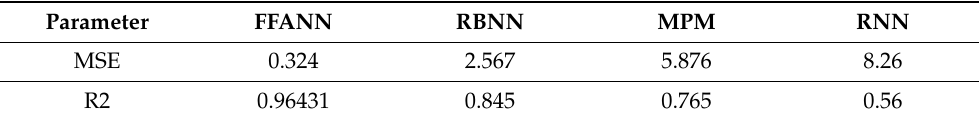
Table 2. Comparative analysis of the ANN types. Parameter